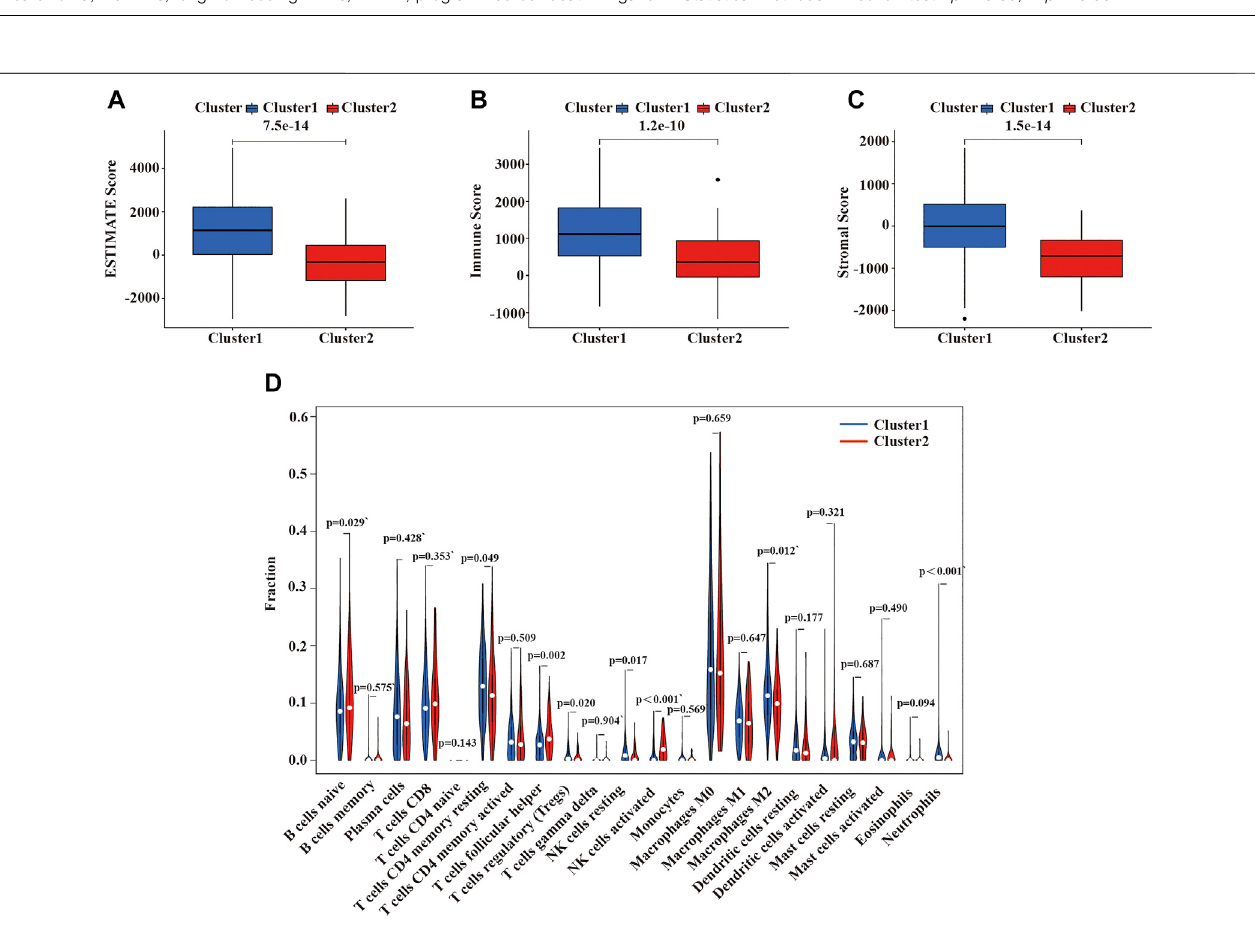
FIGURE5| Immunefunctionandimmunecellin fi ltrationinthetwoclustersofLUSC. (A) ESTIMATEscoreinthetwoclusters. (B) Immunescoreinthetwoclusters. (C) Stroma score in the two clusters. (D) The in fi ltration level of 22 immune cells in the two clusters. LUSC, lung squamous cell carcinoma. Statistical methods: Wilcoxon